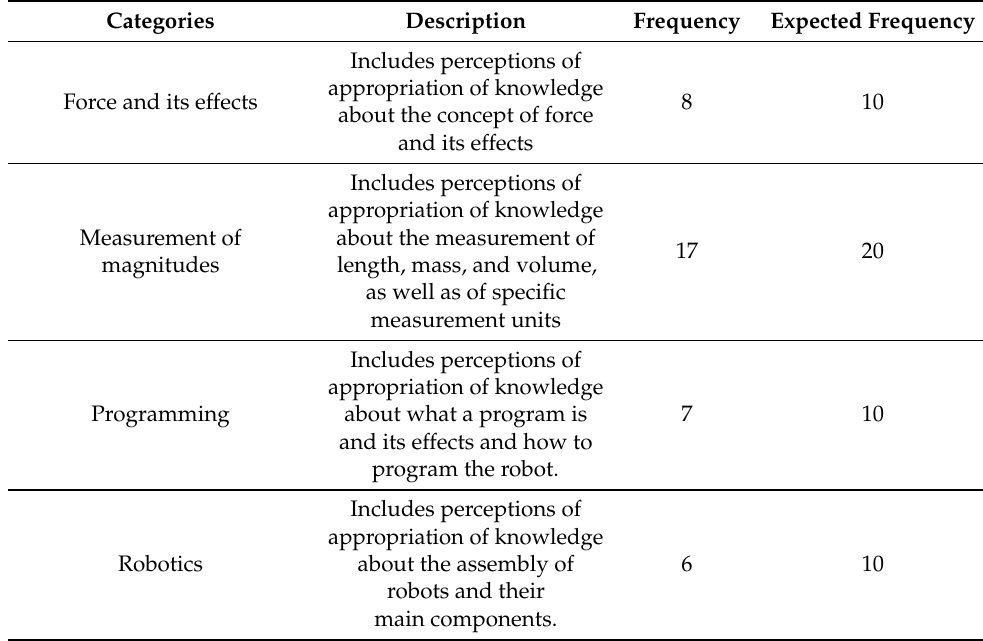
Table 4. Categories of analysis focal group